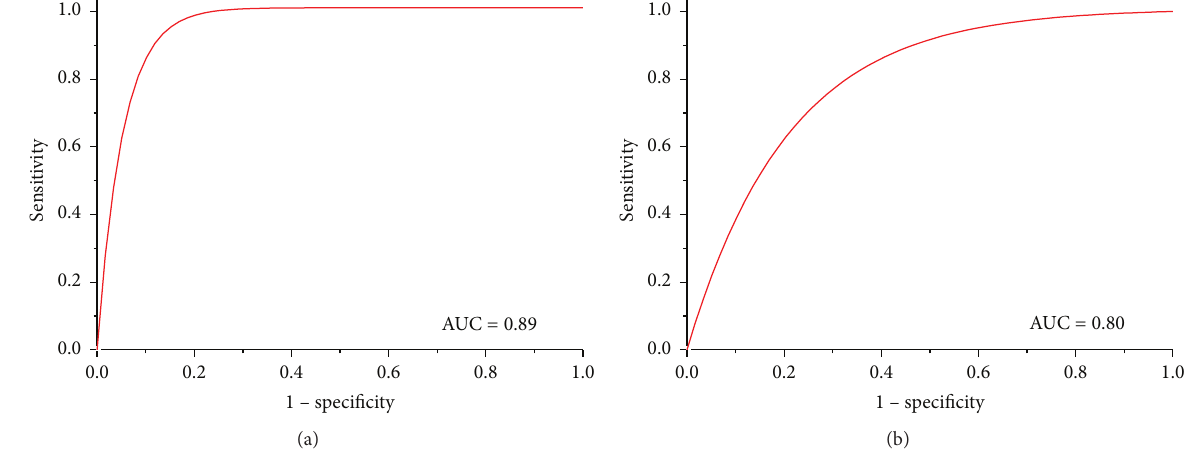
Figure 12: ROC curves obtained from the classification with actual clinical images. (a) Segmentation by SOM network; (b) segmentation by active